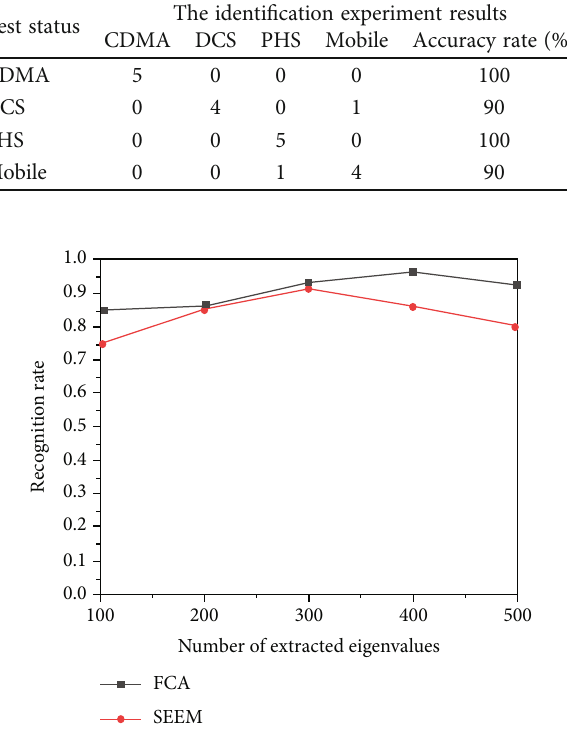
Figure 7: Comparison of SEEM and FCA identi fi cation